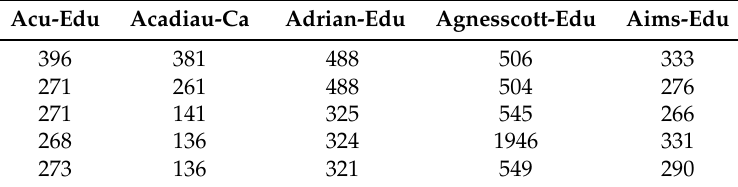
Table 1. Excerpt from the data used in [17], downloaded from [24]; data express latencies measured in